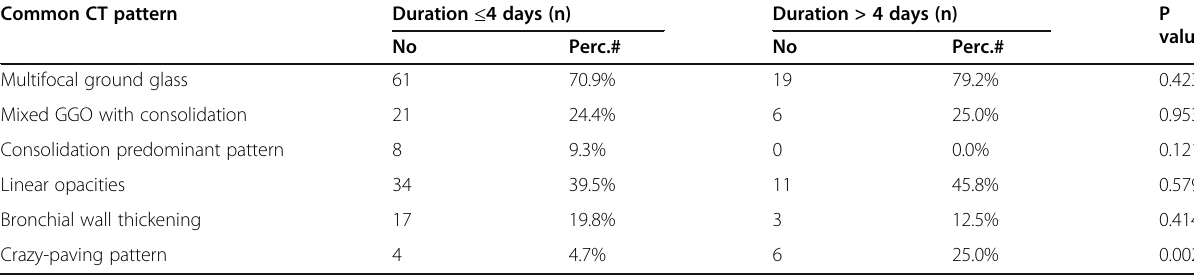
Table 3 The association between common CT pattern with duration of presenting complaint Common CT pattern